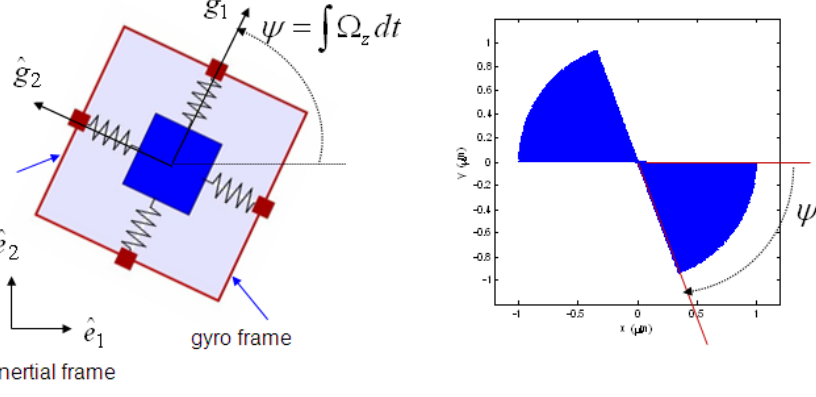
Figure 1. (a) Model of ideal gyroscope. (b) Precession of the proof mass in gyro